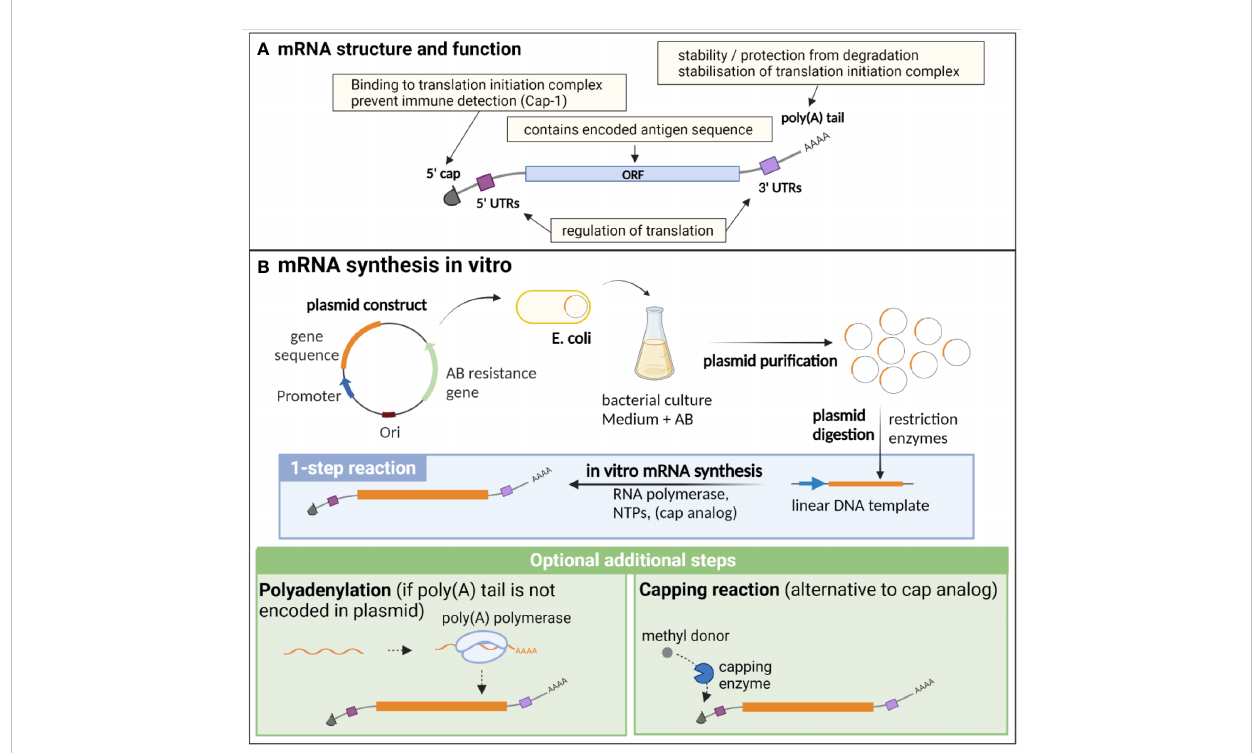
FIGURE 1 Structure, function and in vitro synthesis of vaccine mRNA. (A) mRNA are single stranded nucleic acids composed of an open reading frame (ORF) encoding the gene of interest, fl anked by untranslated regions (UTRs) implicated in translation regulation, a cap at the 5 ’ end consisting of a N7- methylated guanosine residue, important for translation initiation and immune detection, and a poly(A) tail at the 3 ’ end, participating in the stability of the mRNA, as well as the stabilisation of the translation initiation complex. (B) In vitro synthesis of mRNA is often performed from a linearised plasmid template. The gene of interest is encoded in the plasmid template downstream of a promoter sequence. E. coli are transformed with the plasmid and cultured in liquid medium containing an antibiotic for which the plasmid encodes a resistance gene, thereby allowing the selection of bacteria that express the plasmid. The plasmid is then puri fi ed from the culture and digested using restriction enzymes to obtain a linear DNA template. In vitro transcription of mRNA is performed in the presence of the DNA template, an RNA polymerase and nucleotides triphosphates (NTPs). The capping can be performed by directly adding a cap analogue in the IVT reaction mix (1-step reaction), or alternatively by an enzymatic capping reaction after the IVT. If the poly(A) tail is not encoded in the plasmid, an additional step of polyadenylation is required. Created with